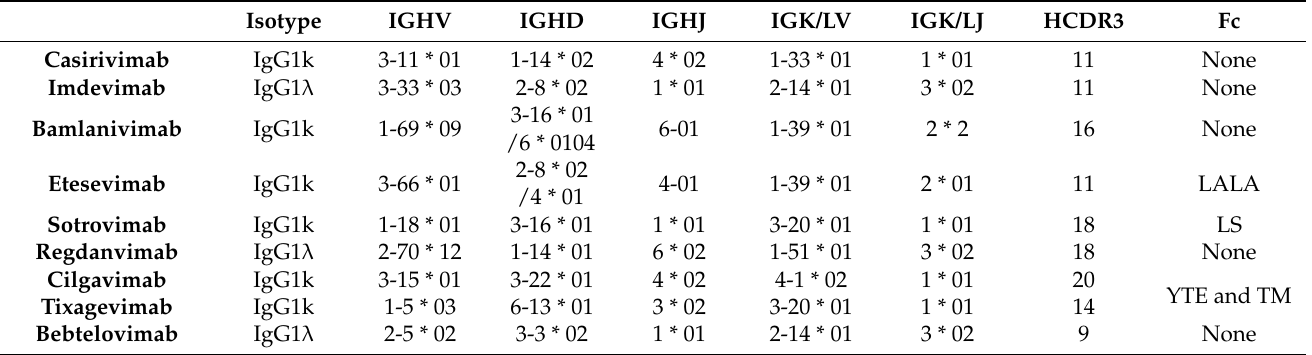
Table 2. Isotype, V regions and Fc characteristics of the FDA- and/or EMA-approved